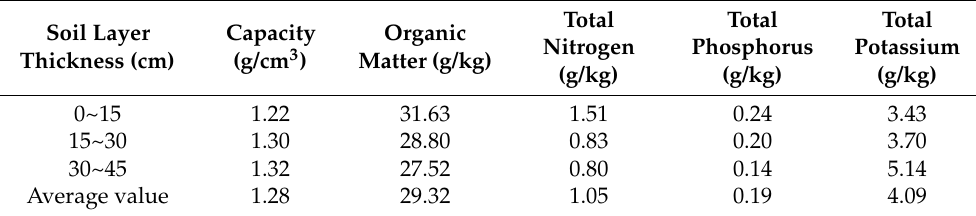
Table 7. Main soil fertility indexes of Liquidambar formosana plantation